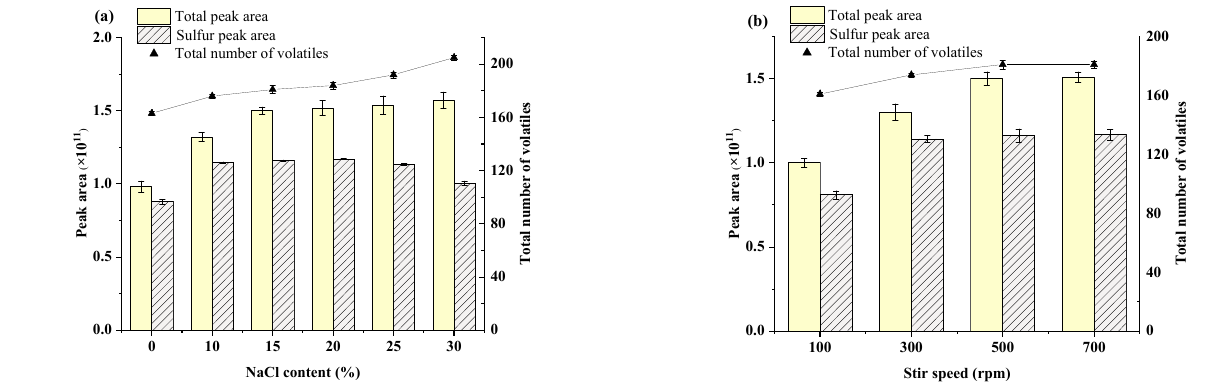
Figure 5. Effect of ( a ) NaCl and ( b ) stir speed on the extraction efficiency of the VOCs.